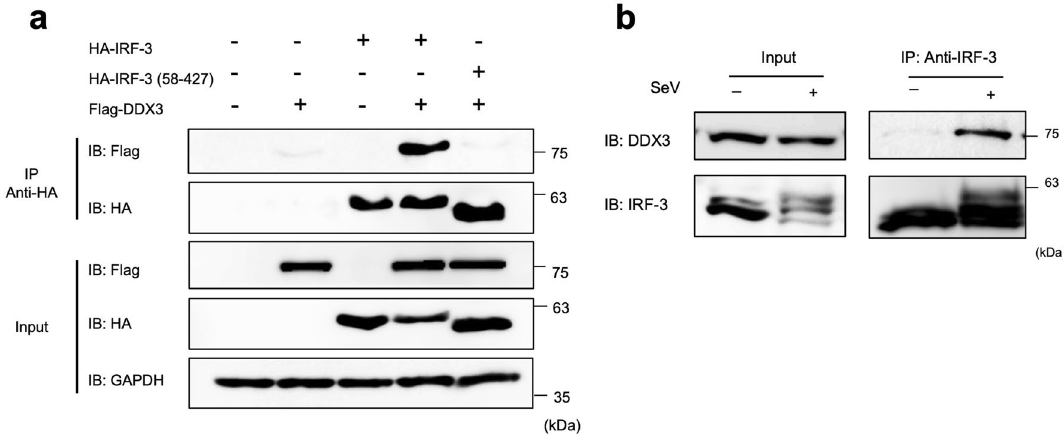
Figure 4. Physical interaction of IRF-3 and DDX3. ( a ) 293T cells were transfected with expression vectors for Flag-DDX3, HA-IRF-3 WT, or HA-IRF-3 (58-427) as indicated. Whole cell lysates were subjected to immunoblotting for Flag or HA epitope (input). Whole cell lysates were immunoprecipitated for HA epitope (IRF-3) and the precipitates were analyzed by immunoblotting for Flag or HA epitope (IP Anti HA). Data are representative of two independent experiments. Full-length gels in Supplementary Information. ( b ) Endogenous interaction between IRF-3 and DDX3 in 293T cells. 293T cells were mock treated or infected with SeV for 12 h. Whole cell lysates were immunoprecipitated by anti IRF-3 and the precipitates were analyzed by immunoblotting for IRF-3 or DDX3. Full-length gels in Supplementary